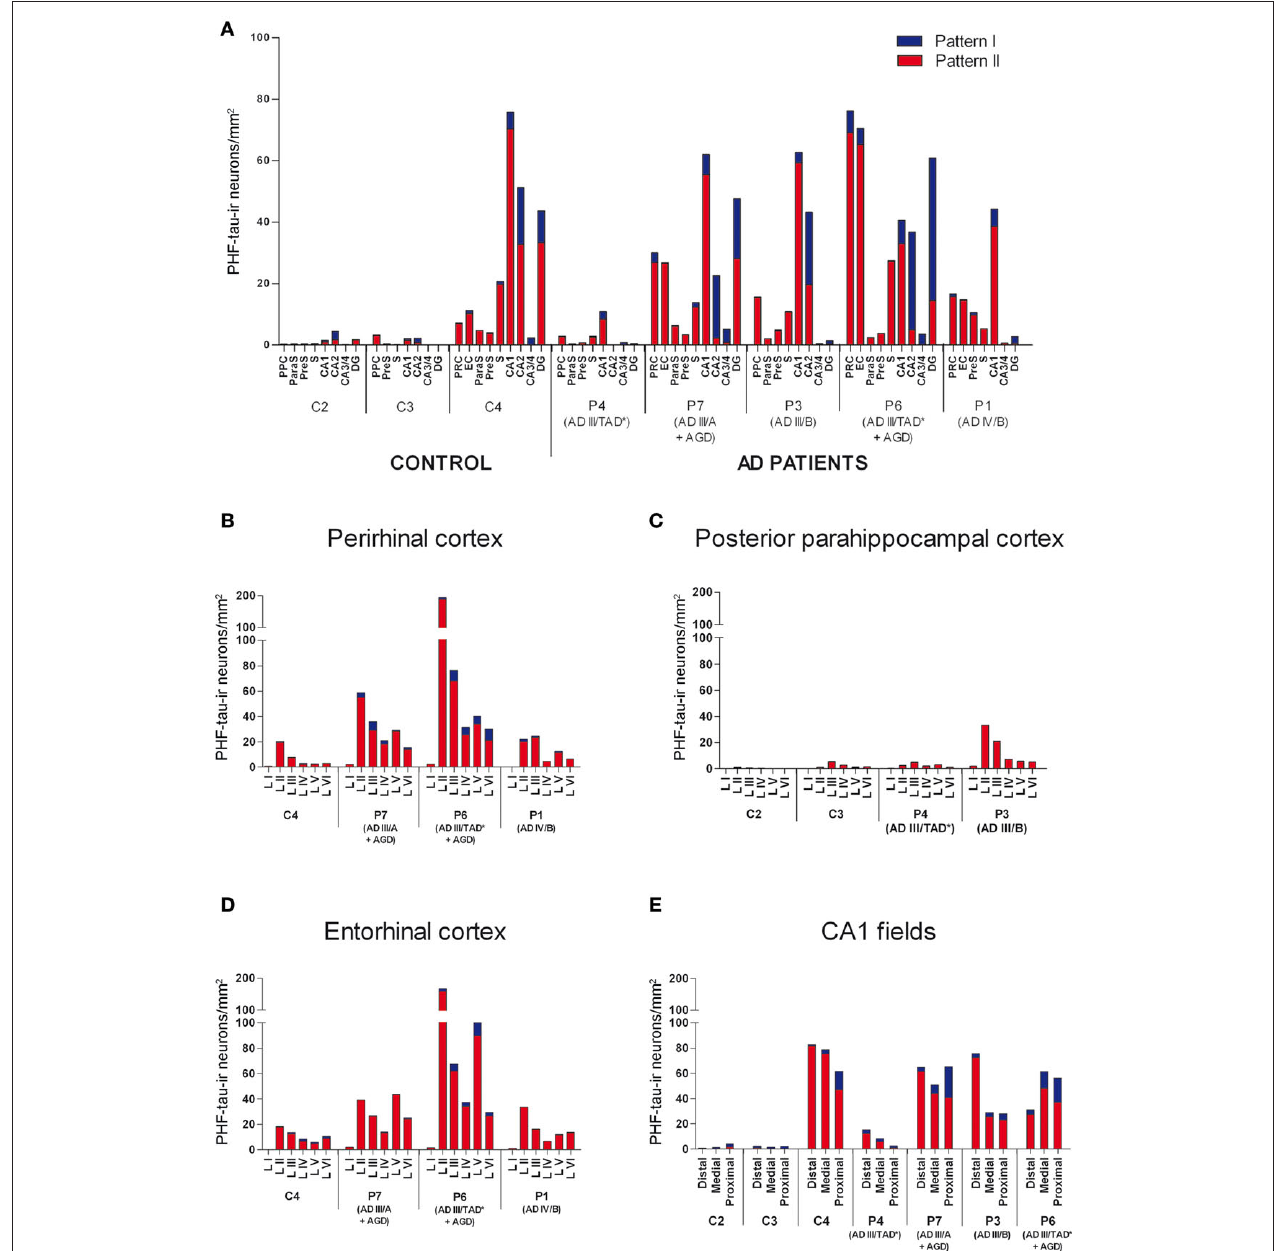
(EC), perirhinal cortex (PRC), and posterior parahippocampal cortex (PPC) . (B–e) Graphs showing the density of PHF-tau-ir neurons with type I and II staining in control and AD patients in the different layers of the PRC, PPC, and EC, and in the pyramidal cell layer of the distal, medial and proximal portions of CA1,